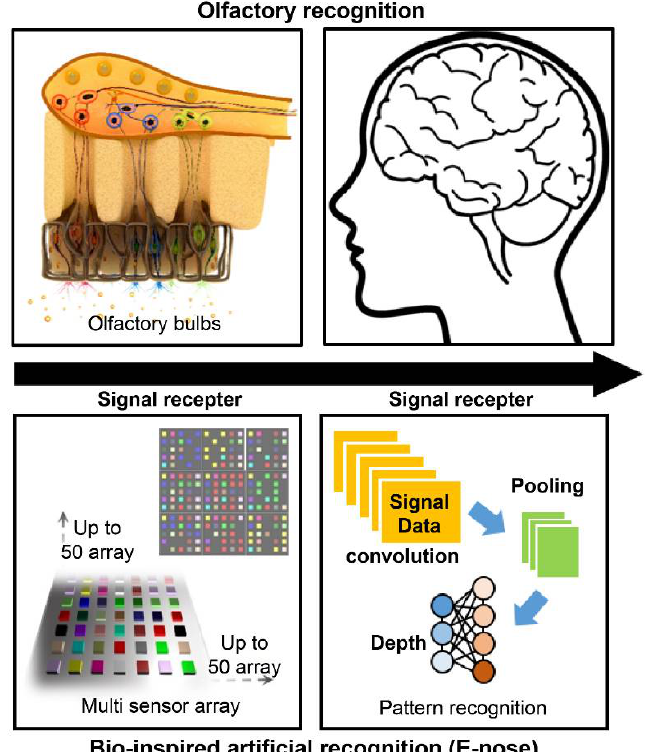
Figure 1. Concept of an artificial nose (e-nose) system based on the olfactory perception pathway.